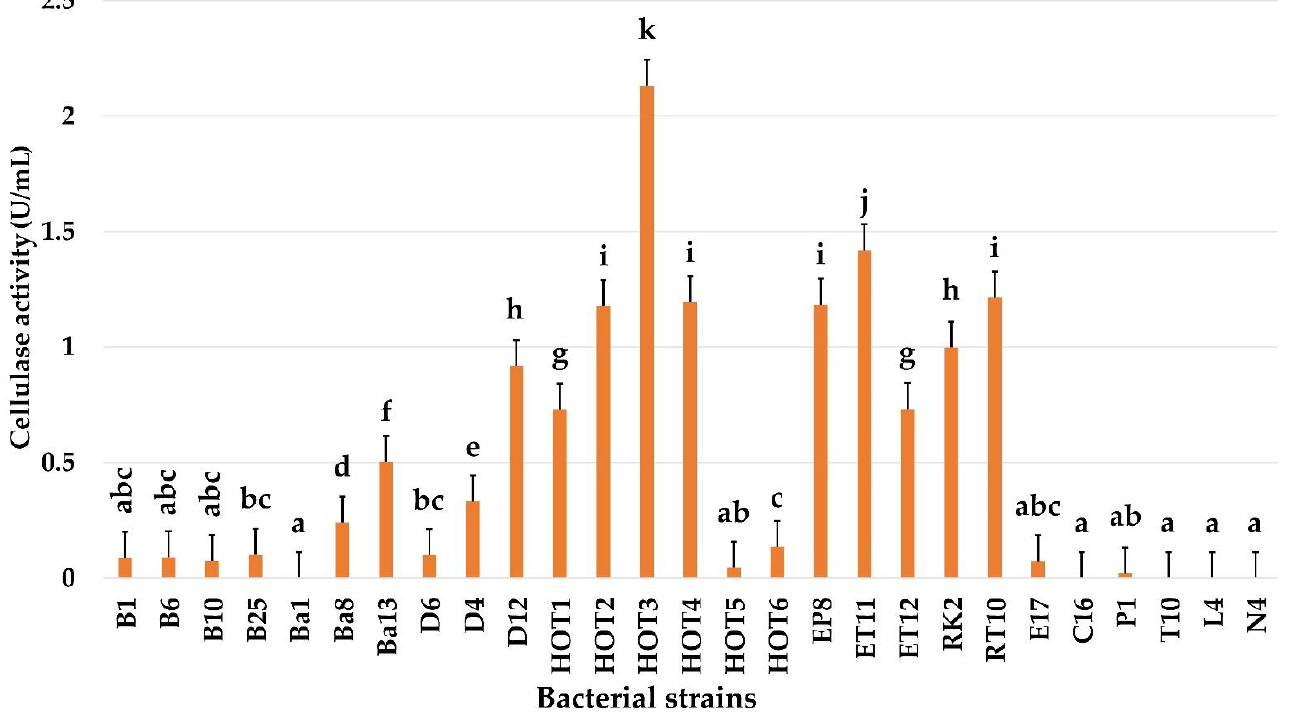
Figure 3. CMCase activity in CMC broth (1%) of the 26 isolates tested. Results are expressed as mean-standard error of duplicate OD values. The cellulase activities corresponding to each treatment and not sharing the same letters are significantly different according to Tukey’s post hoc HSD test.